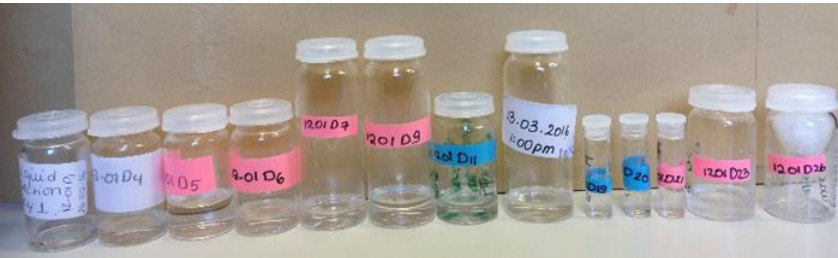
Figure A9. Collected liquid and wax samples postreaction in R4.